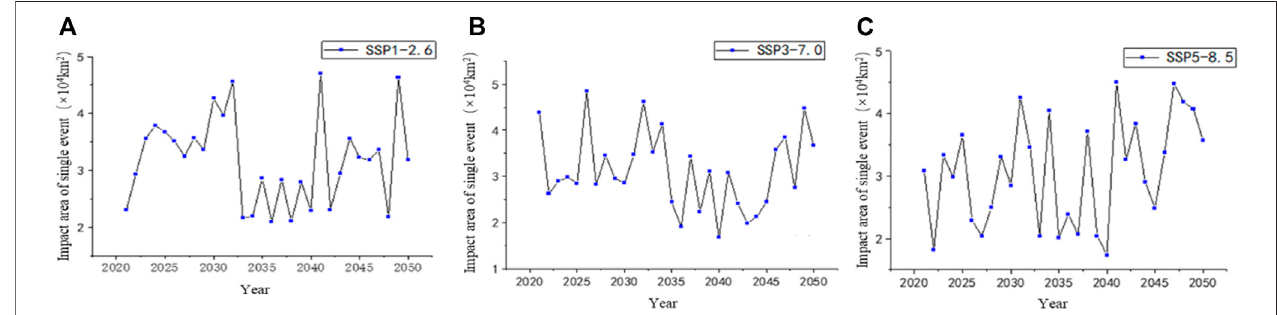
FIGURE 6 | Average annual impact area of extreme precipitation under different scenarios in the future. (A) Under SSP1-2.6. (B) Under SSP3-7.0. (C) Under SSP5-8.5.